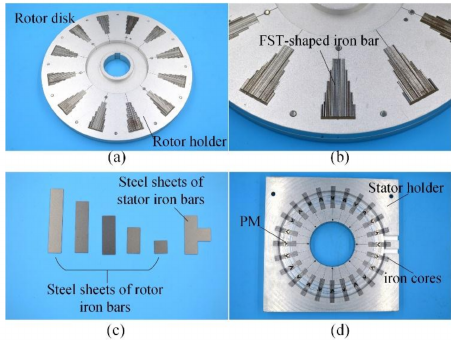
Figure 21. Construction of the prototype: ( a ) Assembled rotor disk; ( b ) FST-shaped iron bar; ( c ) Different kinds of steel sheets; ( d ) Assembled stator